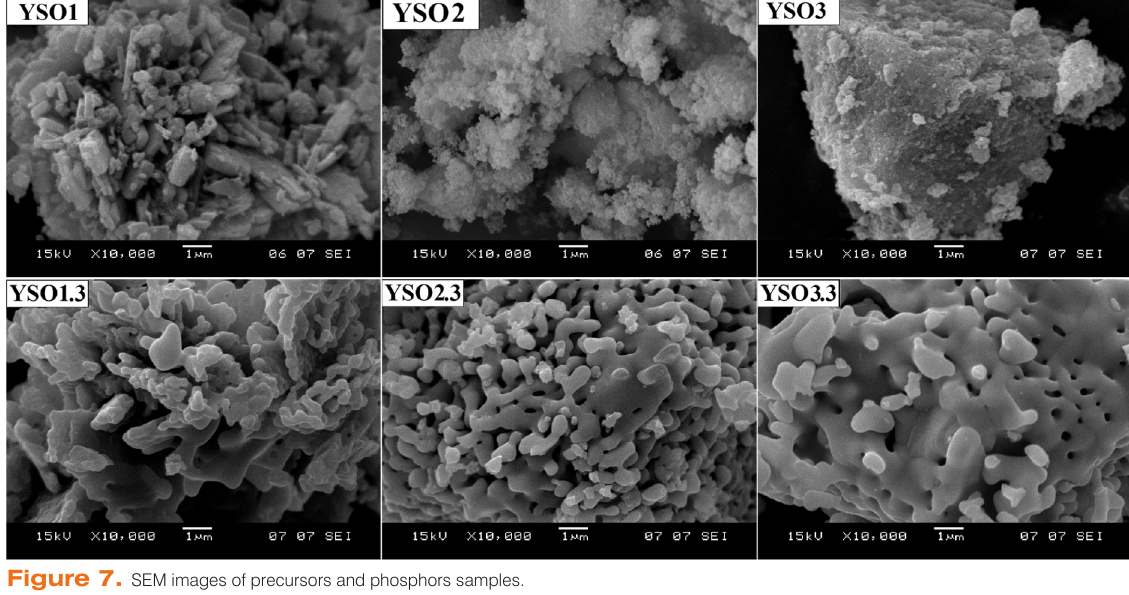
Figure 7. SEM images of precursors and phosphors samples.